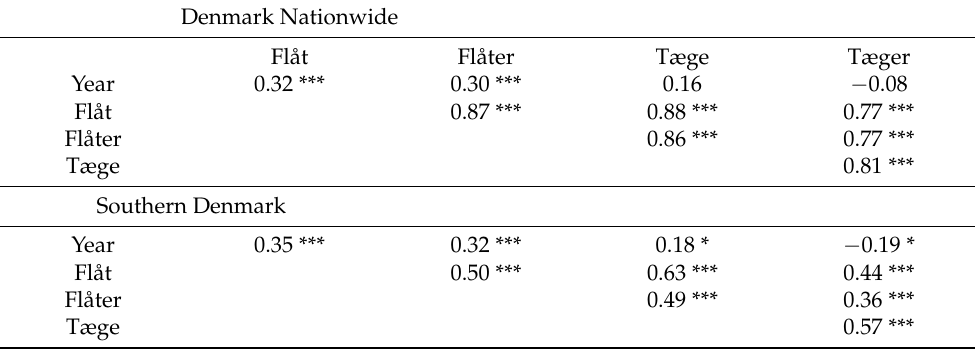
Figure 2. The monthly variation in two Danish tick search terms: “Flåter” and “Tæger” in the period of 2007 to 2019. Table 1. Rank-correlation coefficients for four Danish tick terms and their trend over time (year) on Google Trends. The analyses include the years 2007 to 2019 ( n = 156). *: p < 0.05, ***: p <